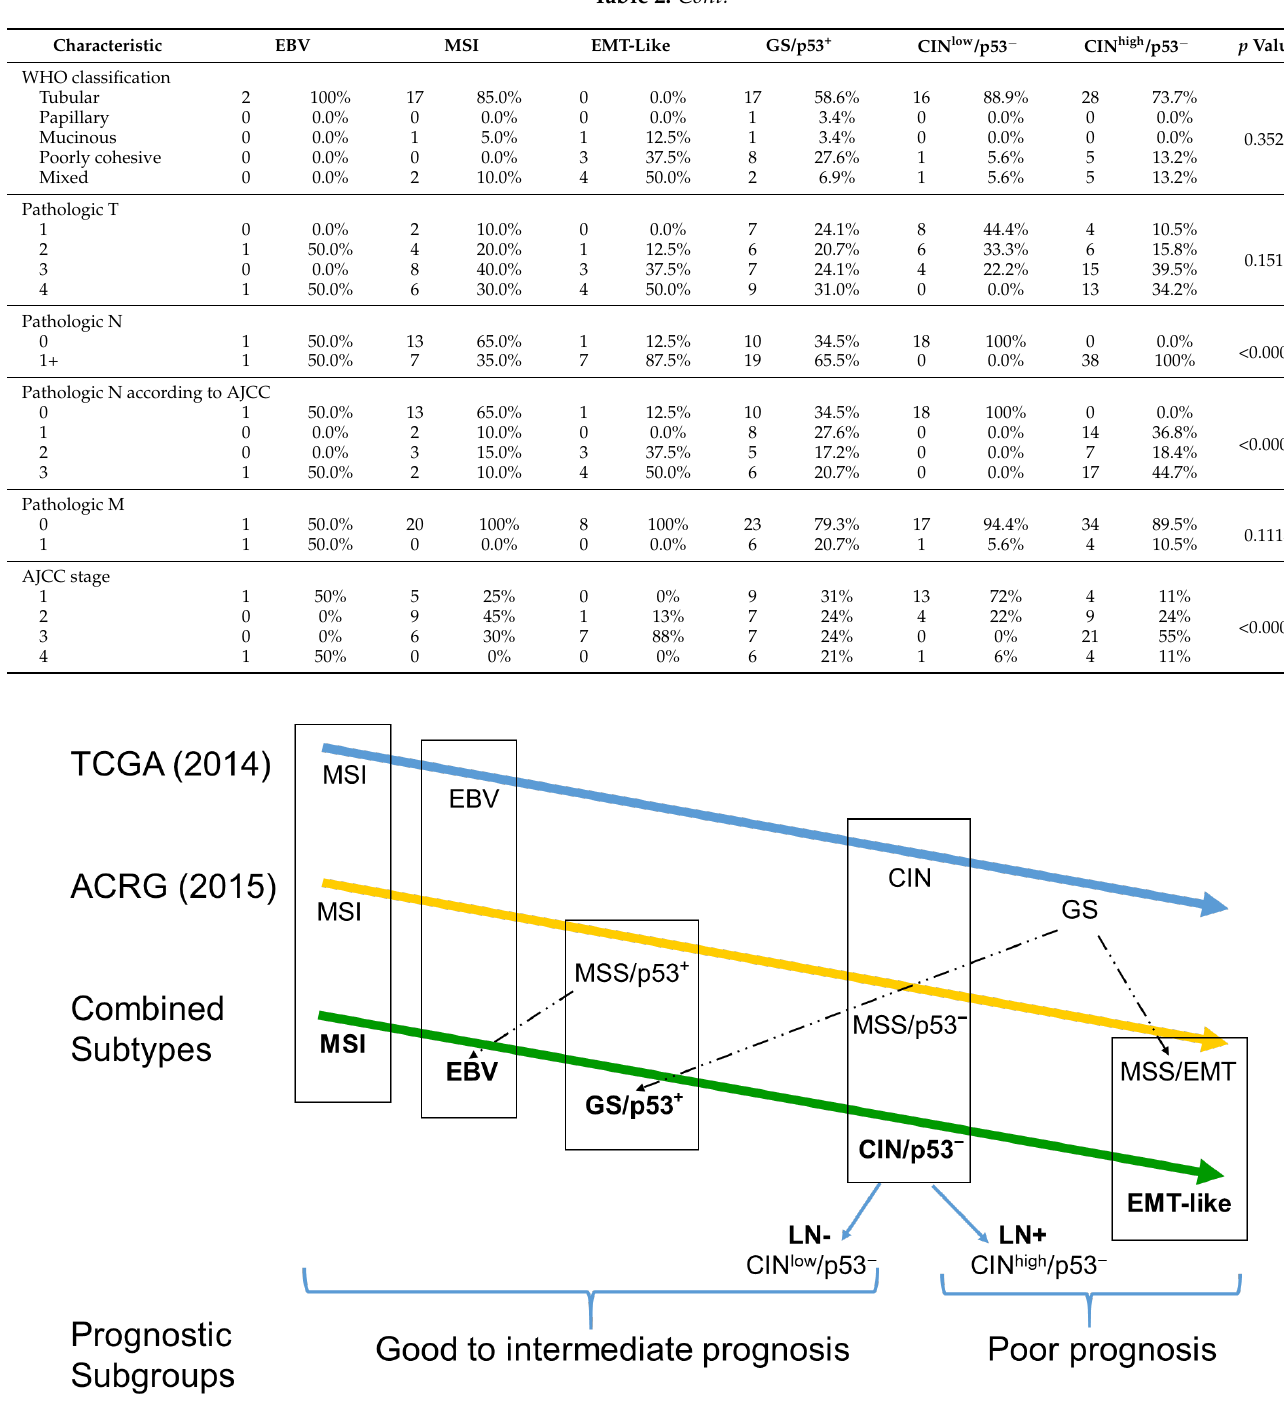
Figure 3. Algorithms of the major molecular classification of GAC, TCGA (blue) and the ACGR (yellow) classification, and the simplified, combined workflow to classify the GCA subtypes used in this study (green). The five subtypes have finally been grouped into two prognostic subgroups with good-to-intermediate and poor prognosis. The nomenclature is based on unique terms (MSI, EBV), similar terms if appropriate (EMT-like) and in a chronologic sequence in case of mixed groups (GS/p53 + , CIN/p53 − ; TCGA: 2014, ACRG: 2015). LN − and LN+: Lymph nodes without and with metastases, respectively.